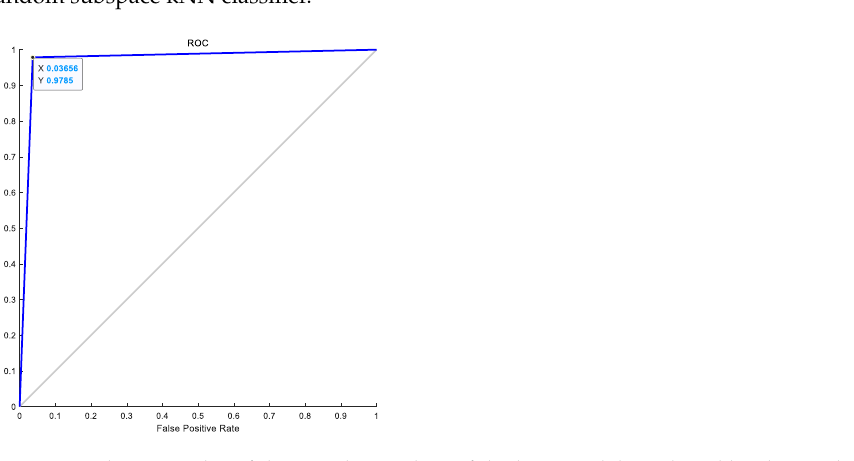
Figure 14. The ROC plot of the simulation data of the best model produced by the random subspace kNN classifier .